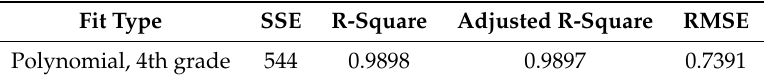
Table 1. Goodness of fit of Equation